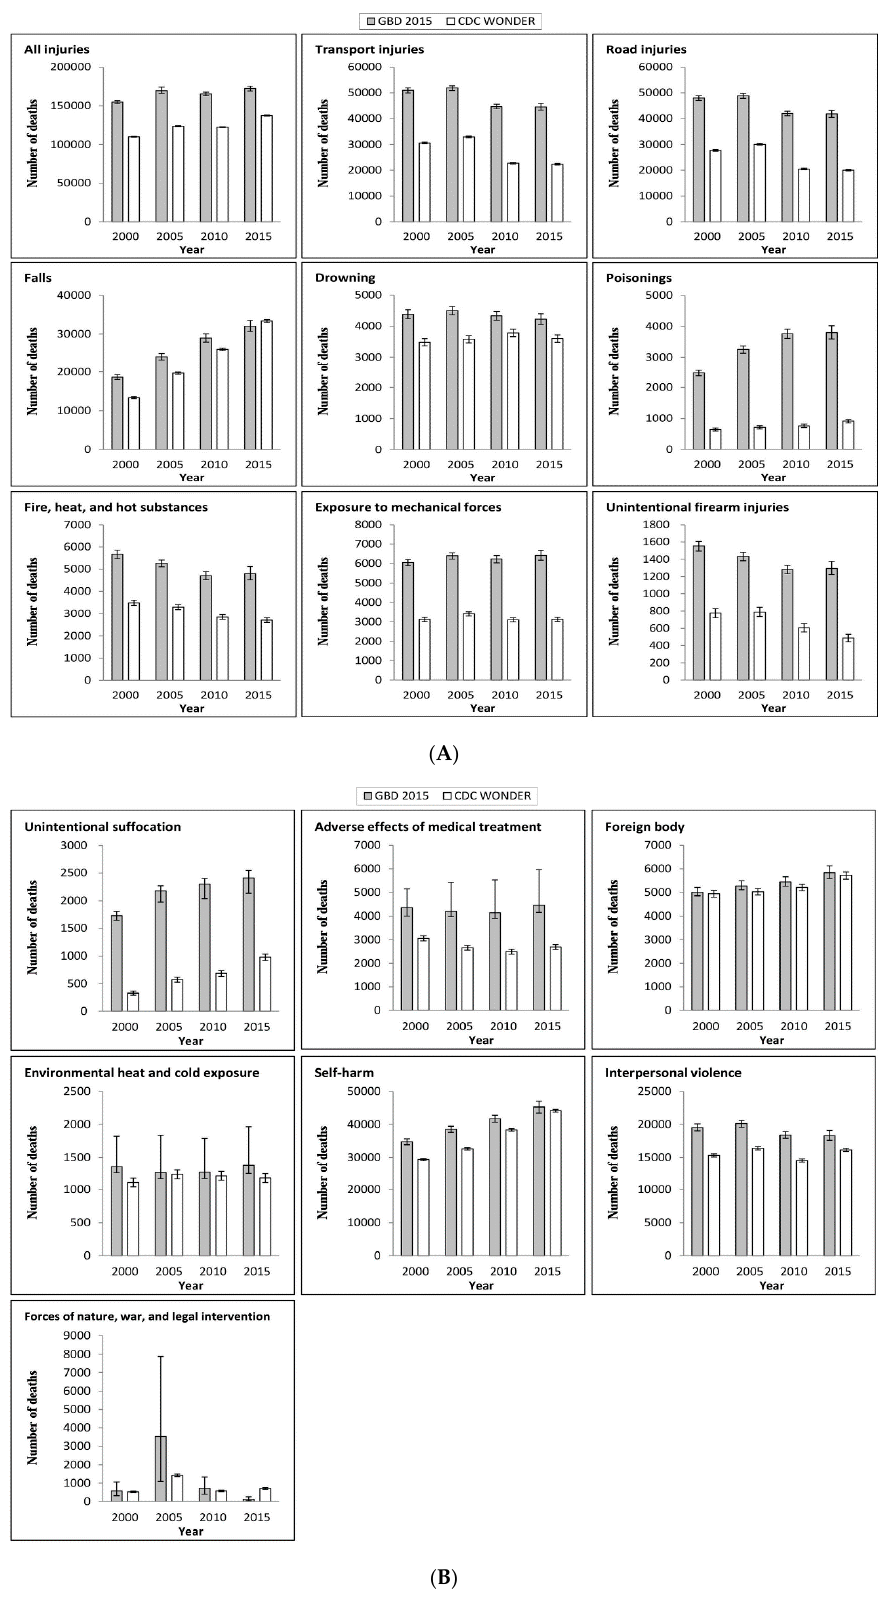
Figure 1. Injury deaths by cause from GBD 2015 and U.S. CDC WONDER (2000–2015). ( A : all-cause injury and cause 1–8; B : cause 9–16). Note: Error bars indicate 95% uncertainty intervals from GBD 2015 estimates and 95% confidence intervals from CDC WONDER, respectively.